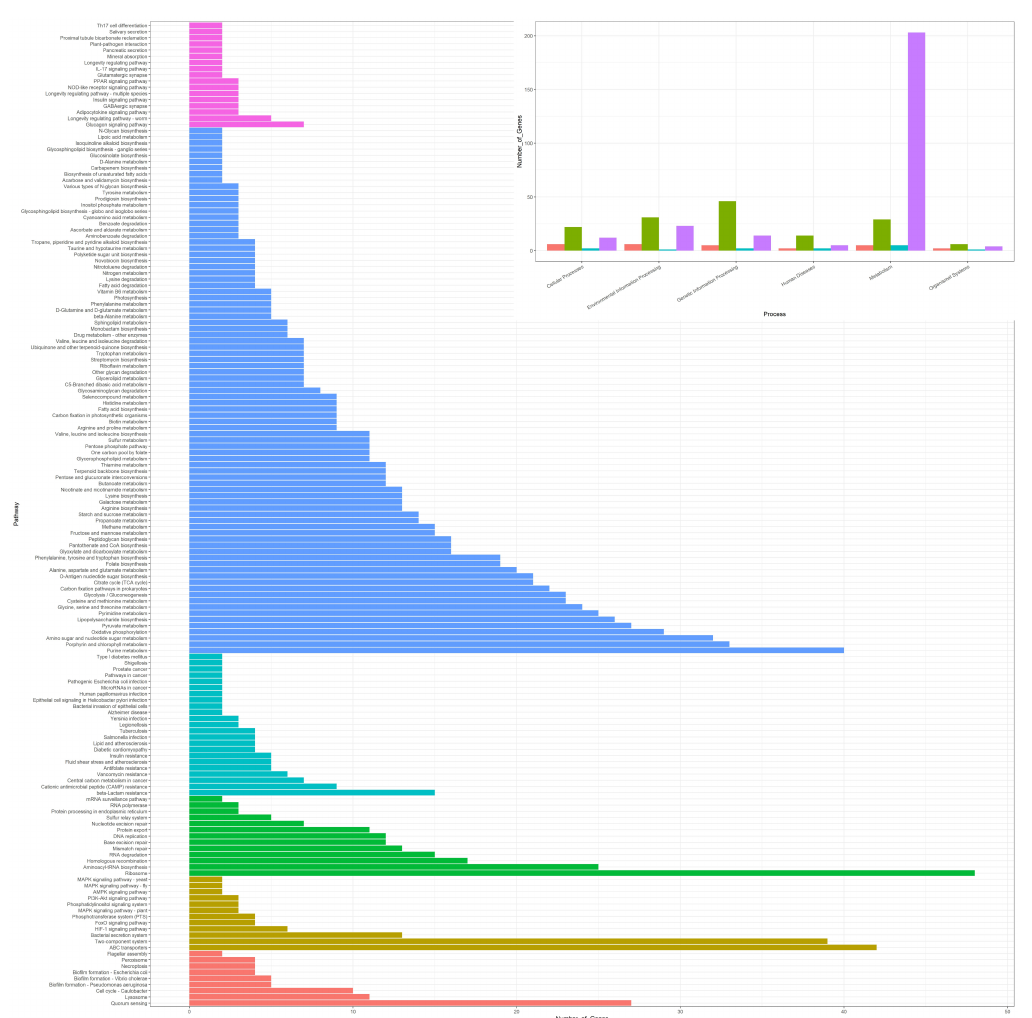
Figure 5. KEGG pathway annotation by KAAS. The majority of genes in the genetic information processing, environmental information processing, and cellular processes belong to the core genome. Furthermore, the species has been found to carry diverse metabolic potential and is involved in many important biological pathways such as vitamin synthesis and synthesis of secondary